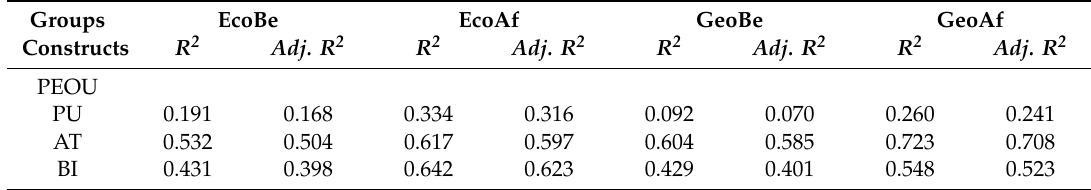
Table 5. The goodness of fit for the structural model through.